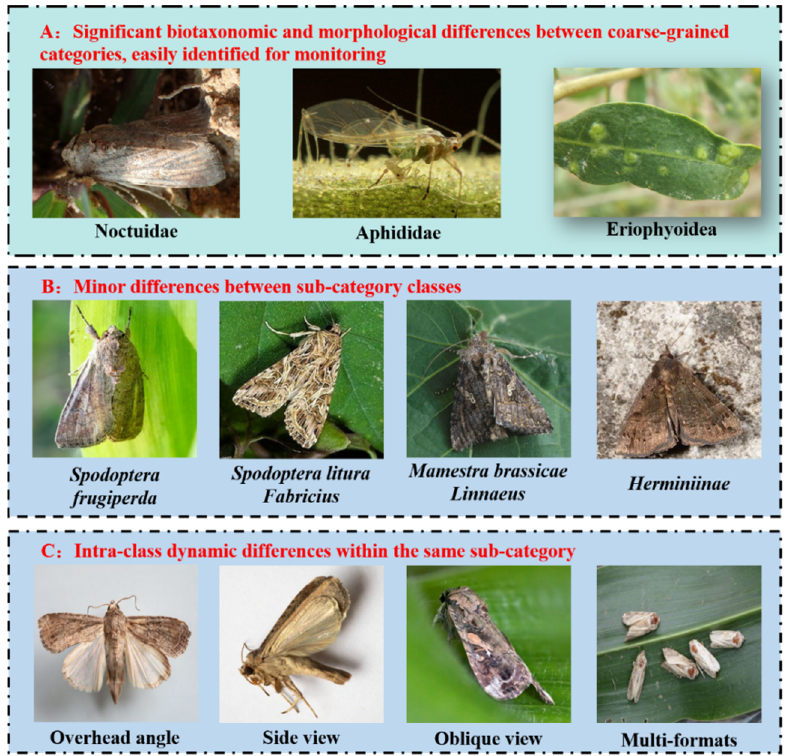
Figure 1. Fine ‐ grained recognition illustration of crop pests and diseases in complex agricultural